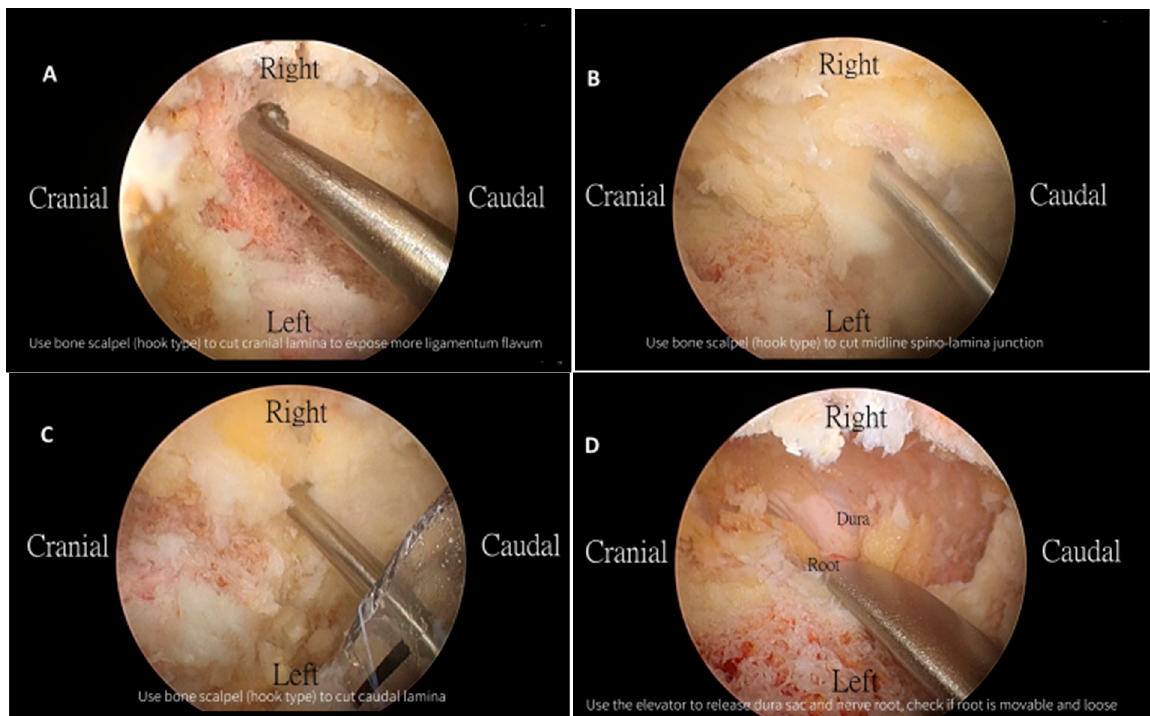
Figure 2. Intraoperative images of the technical use of UBS for decompression. ( A ). The use of the UBS hook type to cut the cranial lamina. ( B ). The use of the UBS hook type to cut the midline spinolaminar junction. ( C ). The use of the UBS hook type to cut the caudal lamina. ( D ). After decompression, we used the elevator to separate the dural sac and nerve root to check if the root was movable and loose.